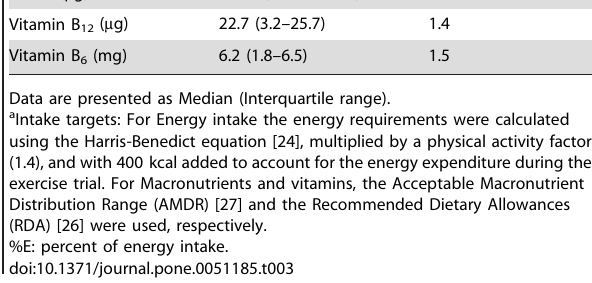
exercise to increase tHcy, while others described a decrease in this